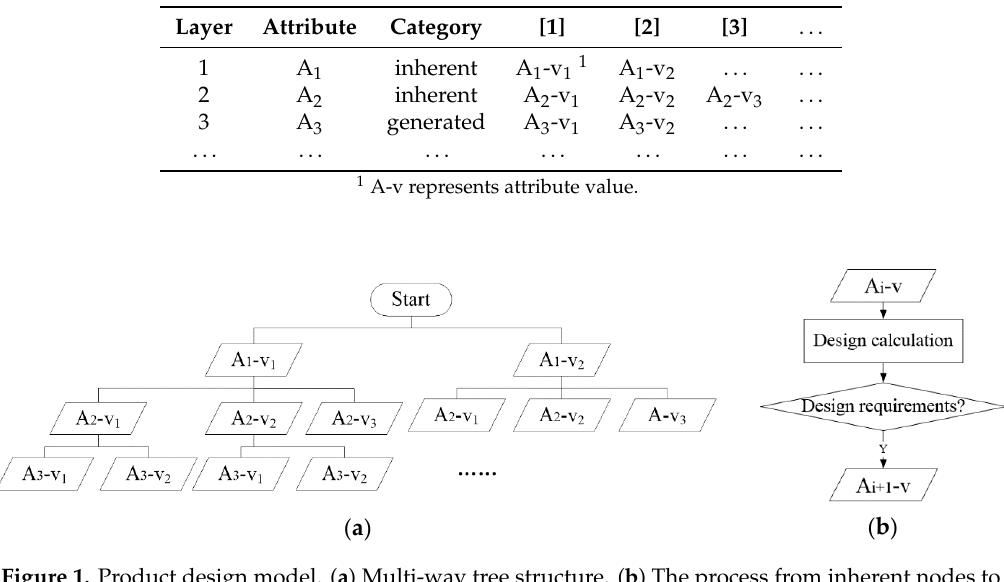
Figure 1. Product design model. ( a ) Multi-way tree structure. ( b ) The process from inherent nodes to generated nodes.